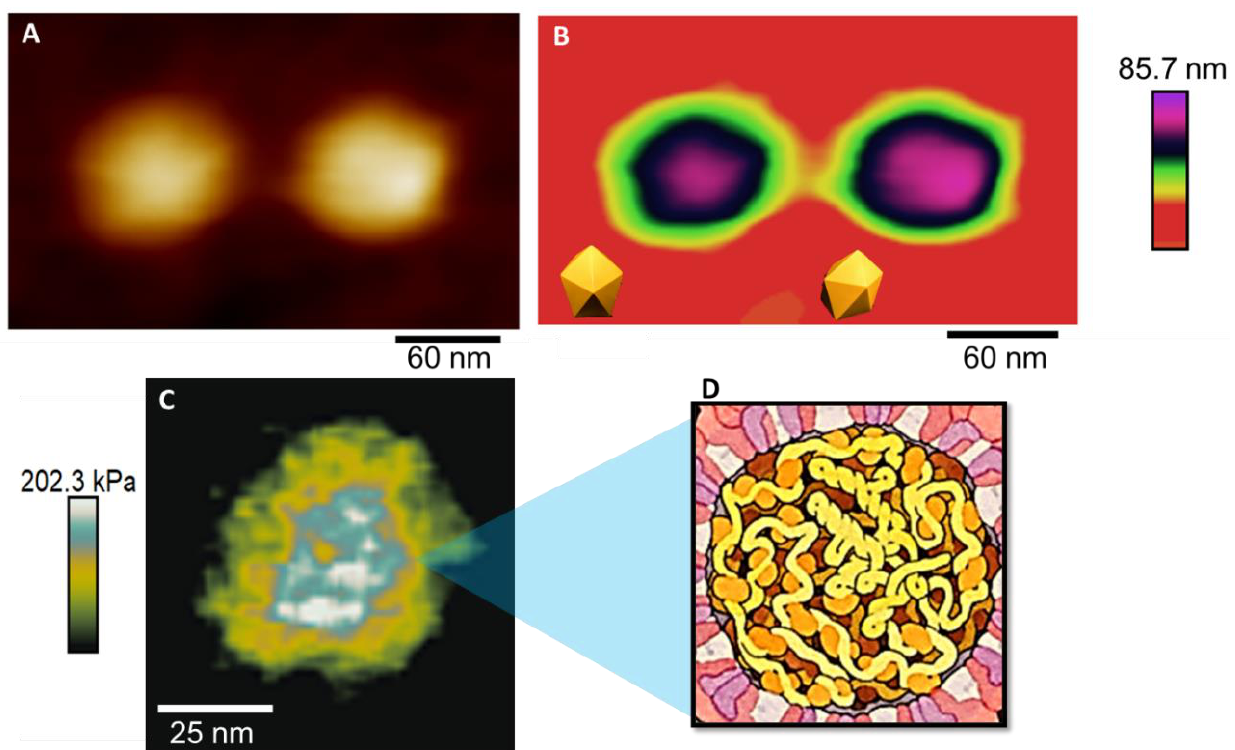
Figure 2. ( A ) Heightmap of two ZIKV particles; ( B ) The same particles with a different height scale contrast, evidencing the icosahedral type of the adsorption pattern. ( C ) Young Modulus map showing internal structure arrangement. ( D ) Pictographic representation of the internal assembly of the ZIKV [35].